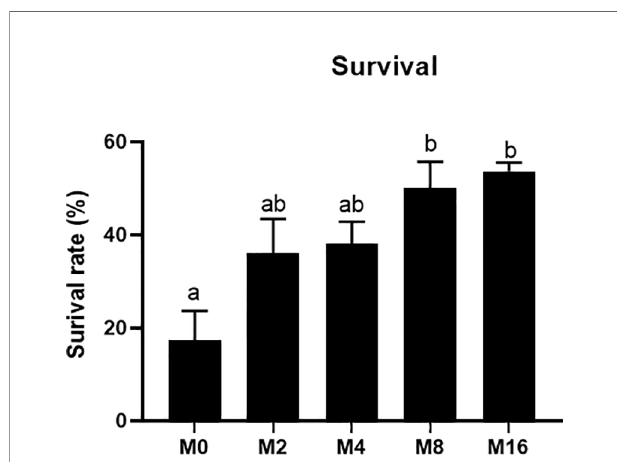
FIGURE 8 | Effects of dietary MOS on mortality rate of Litopenaeus vannamei challenged with Vibrio parahaemolyticus . a,b Value bars not sharing the same superscript letter are signi fi cantly different as evaluated by Tukey ’ s test ( p < 0.05). MOS, mannan